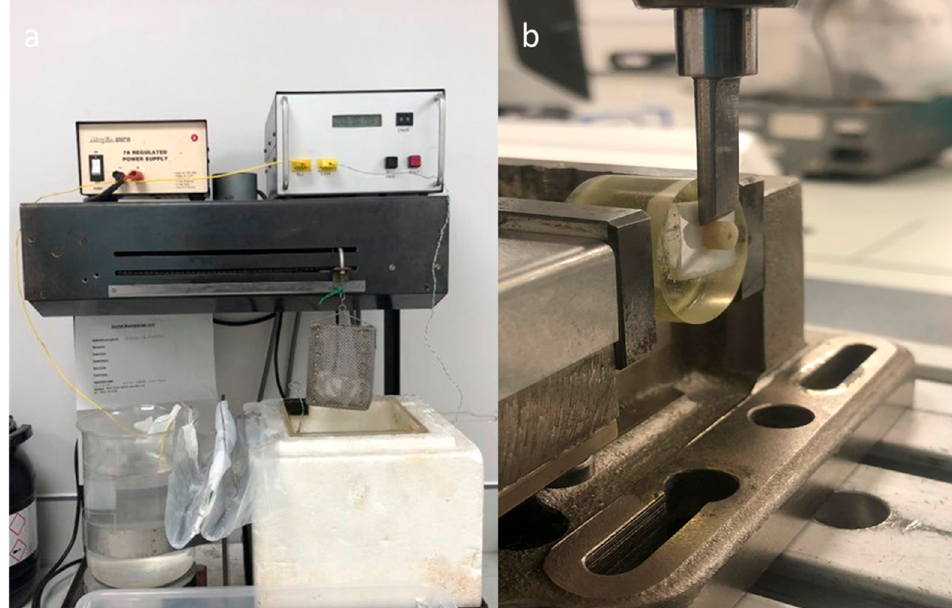
Figure 5. Bonded specimens underwent 10,000 thermocycles between 5 °C and 55 °C ( a ) before being tested for shear bond strength (SBS) ( b